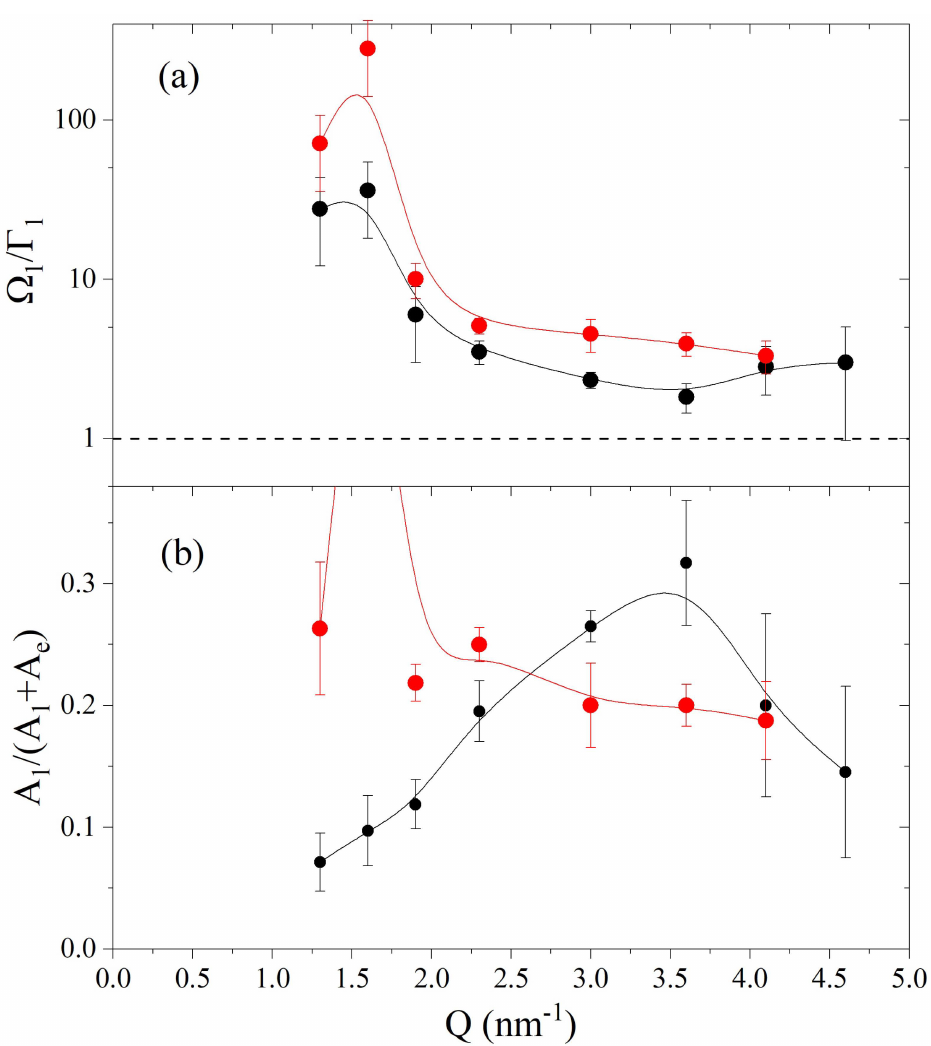
Figure 5. Panel ( a ) displays the Q –dependence of the inverse of the relative damping Ω 1 / Γ 1 of the best–fitting DHO model profile (see text). Panel ( b ) shows the area of the DHO component relative to the one of the entire best fitting model. Symbols and colors are as in Figure 4. Notice that the Q = 1.5 nm − 1 value falls well beyond the plot